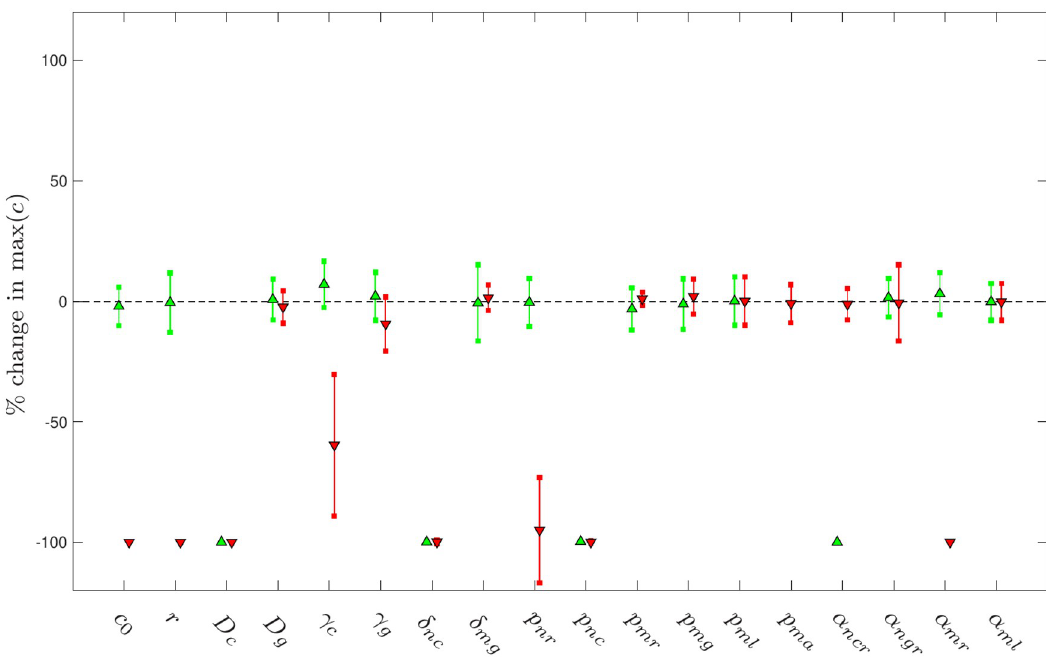
Fig 12. Percentage change in the maximal level of pro-inflammatory mediator c at t = 5000 on varying each individual parameter by + 50% (green) and − 50% (red), from the baseline parameter values given in Table 1, with healthy choices of chemotaxis parameters ( k grad = 80, σ mem = 1). Triangles denote the mean percentage change in the response; error bars denote plus/minus one standard deviation. (For probabilities for which an increase of 50% results in a choice greater than one, the green results correspond to simulations with unit probability.) Note that a change in response of − 100% corresponds to a switch from a chronic to a healthy outcome.